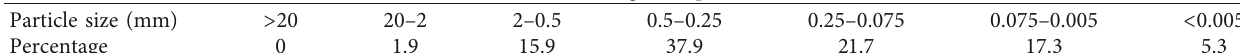
Table 1: Grading sand particles.